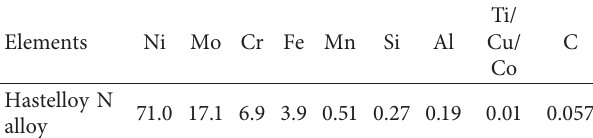
Table 1: Chemical composition of the Hastelloy N superalloy (wt.